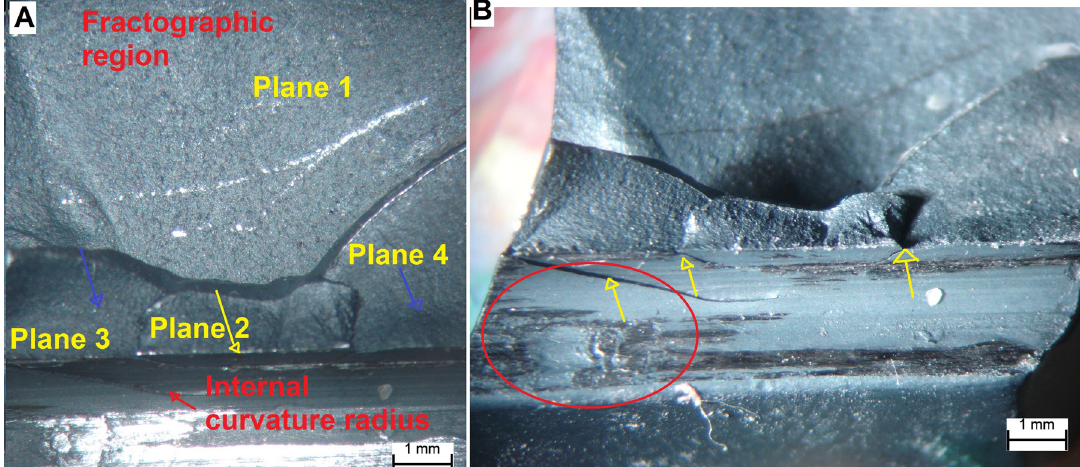
Figure 7. Stereographic images of the fracture surface of the P2 blade. (A)The crack nucleation sites (yellow arrow). There are four different fatigue crack propagation planes, plane 1 (bottom), planes 2, 3, and 4 (top). (B) Detail of (A) observed by another angle.